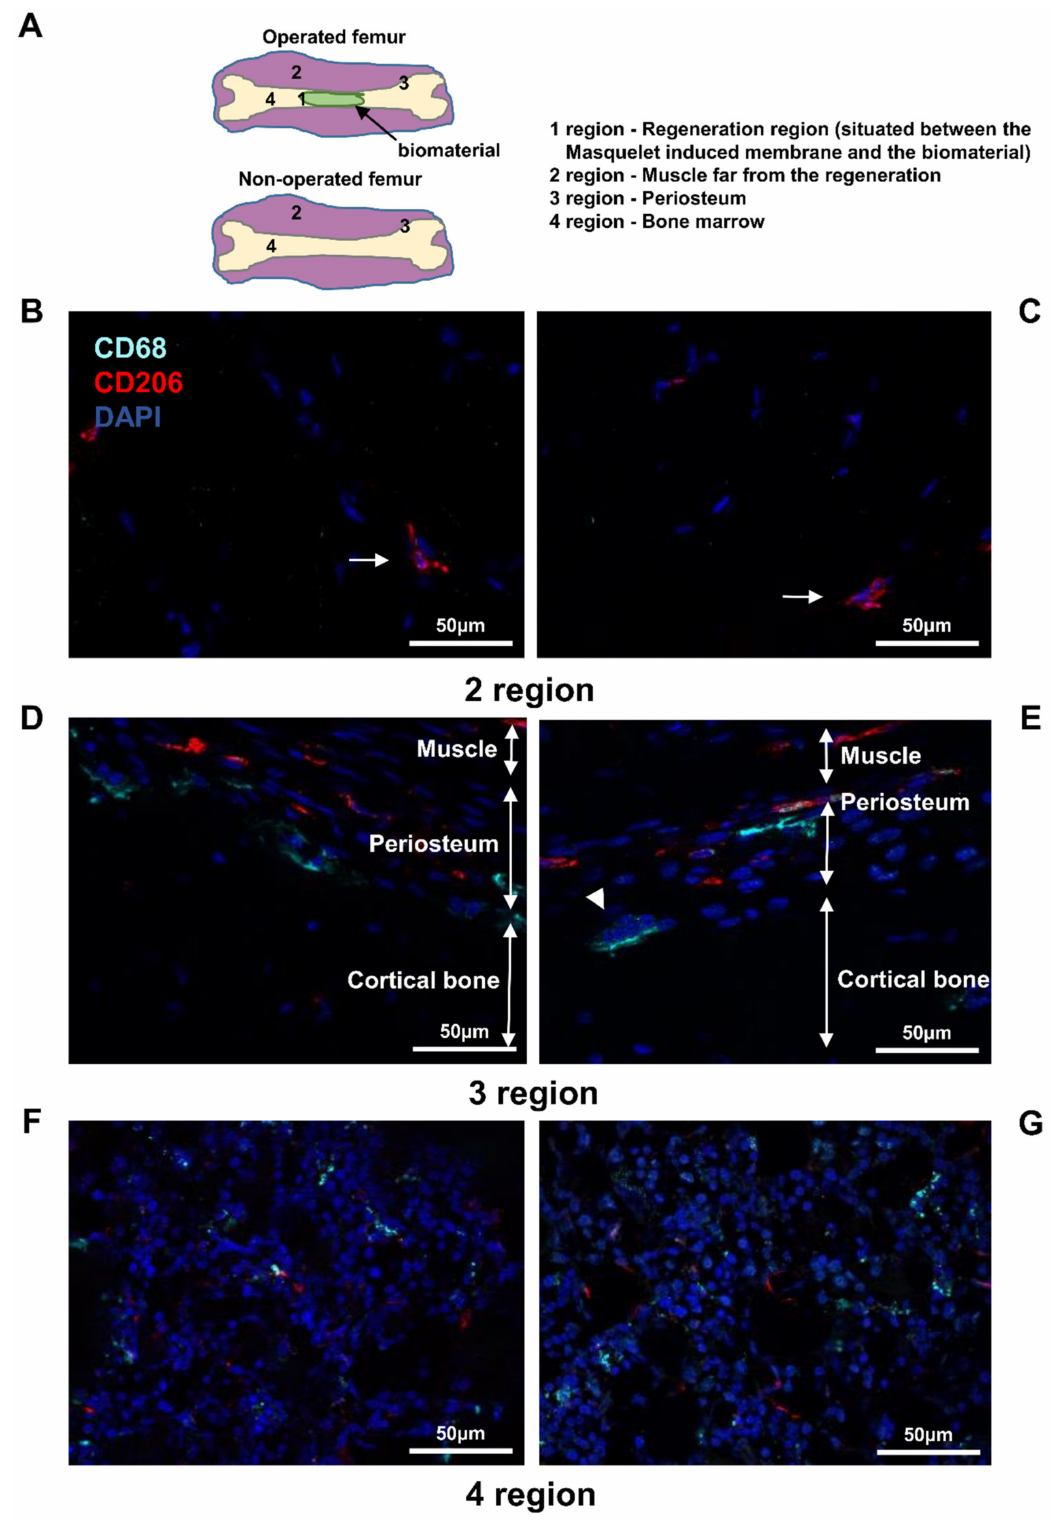
Figure 5. Identification of M1-like and M2-like macrophages in the rat femurs: ( A ) presentation of the different regions of the femurs; ( B , D , F ) operated; and ( C , E , G ) non-operated femurs labeled with anti- CD68 and anti-CD206 antibodies; anti-CD68 (Alexa488, turquoise fluorescence), labeling the M1 and M2 macrophages; anti-CD206 (Alexa568, red fluorescence) labeling the M2 macrophages and satellite cells; nuclear staining with DAPI (blue fluorescence); thin arrow: satellite cells; arrowhead: